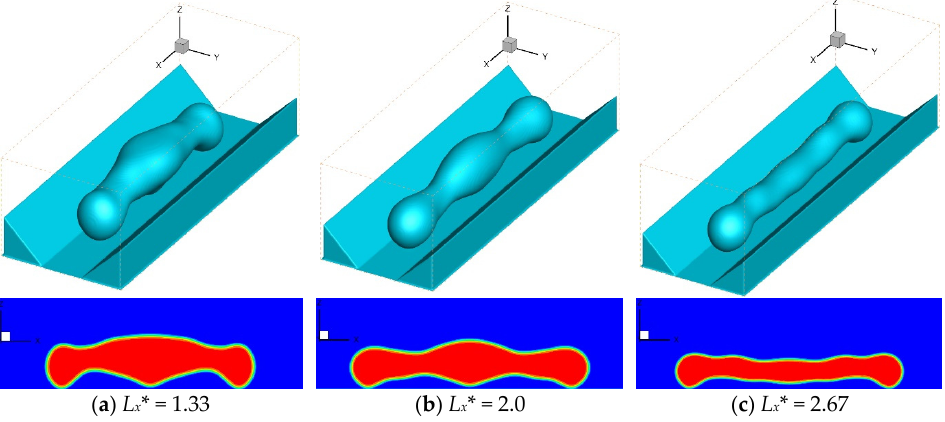
Figure 12. The morphologies of the droplets at various L x * on the S1 surface with L y * = 0.67. ( a ) L x * = 1.33. ( b ) L x * = 2.0. ( c ) L x * = 2.67.